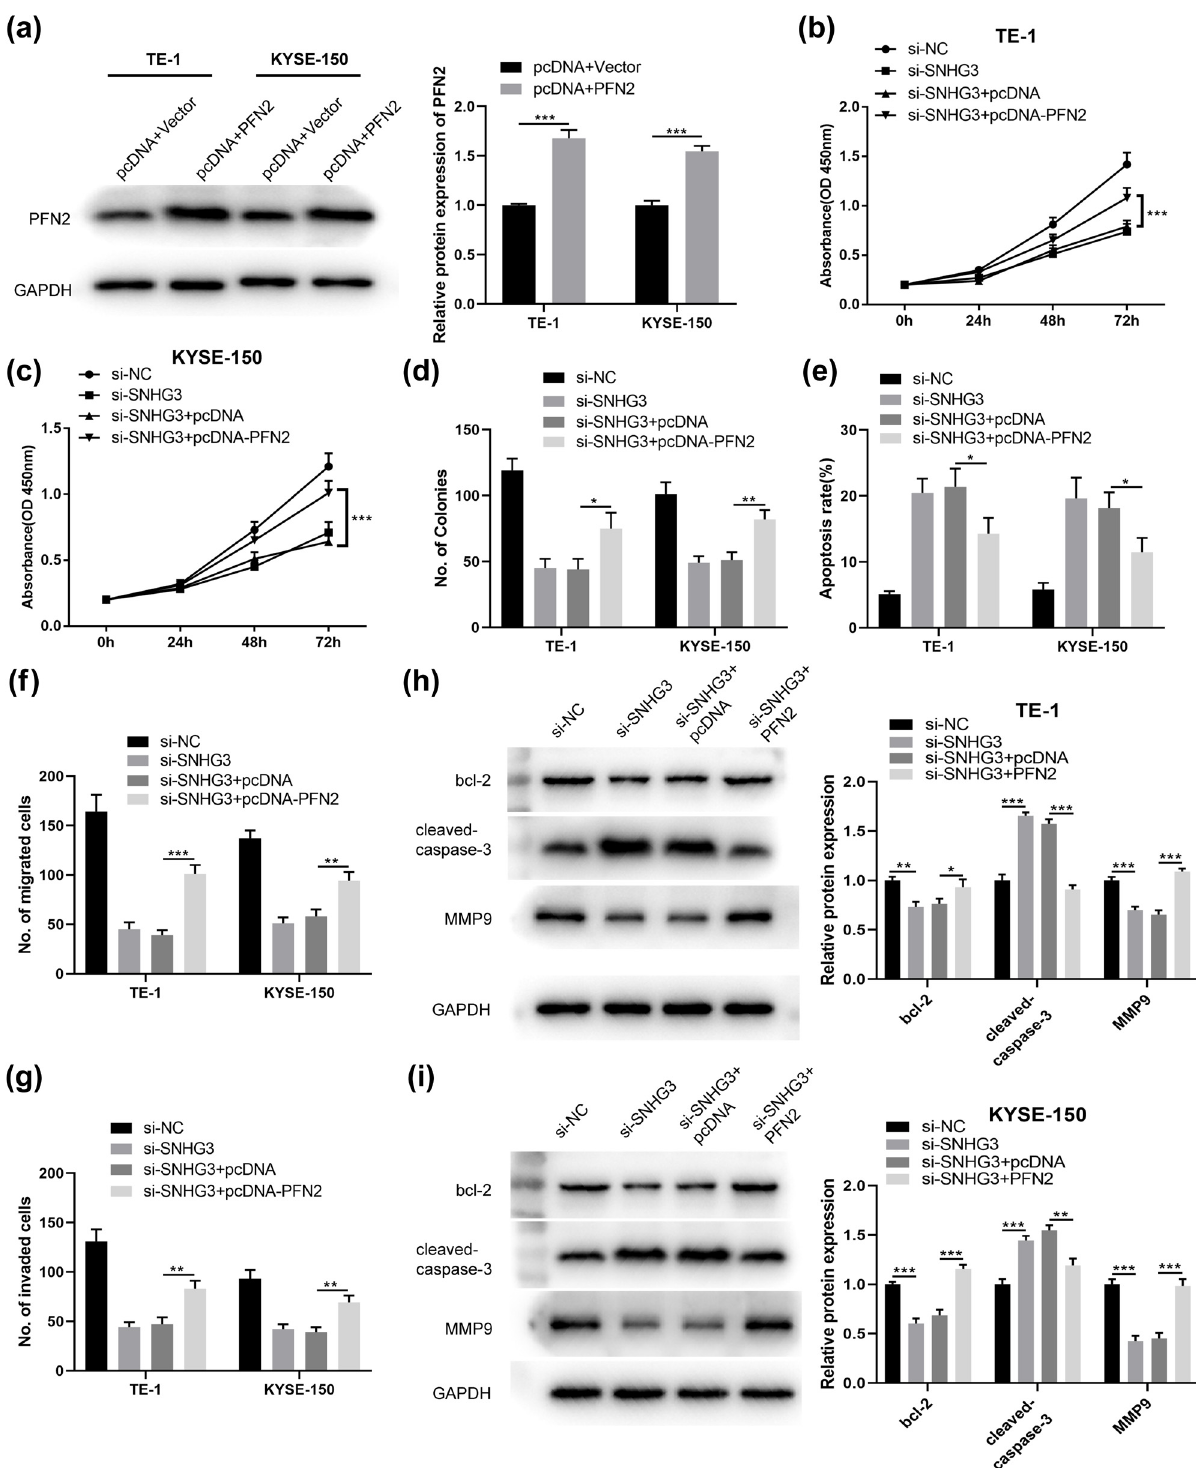
Figure 6: PFN2 overexpression abolished the e ff ects of lncRNA SNHG3 knockdown on cell proliferation and metastasis. ( a ) The protein level of PFN2 in cells transfected with pcDNA - vector or pcDNA - PFN2 was measured. ( b and c ) CCK - 8 assay was performed for cell proliferation in TE - 1 and KYSE - 150 cells. ( d ) Colony formation assay was used to analyze cell colony formation ability in ESCC cells. ( e ) Flow cytometry was employed to evaluate cell apoptosis. Transwell assay was carried out for cell migration ( f ) and invasion ( g ) . ( h and i ) Western blot assay was used to detect the protein levels of bcl - 2, cleaved - capsase - 3, and MMP9 in TE - 1 and KYSE - 150 cells. ( b – i ) TE - 1 and KYSE - 150 cells were transfected with si - NC, si - SNHG3, si - SNHG3 + pcDNA - NC, or si - SNHG3 + pcDNA - PFN2. * P < 0.05, ** P < 0.01, *** P <